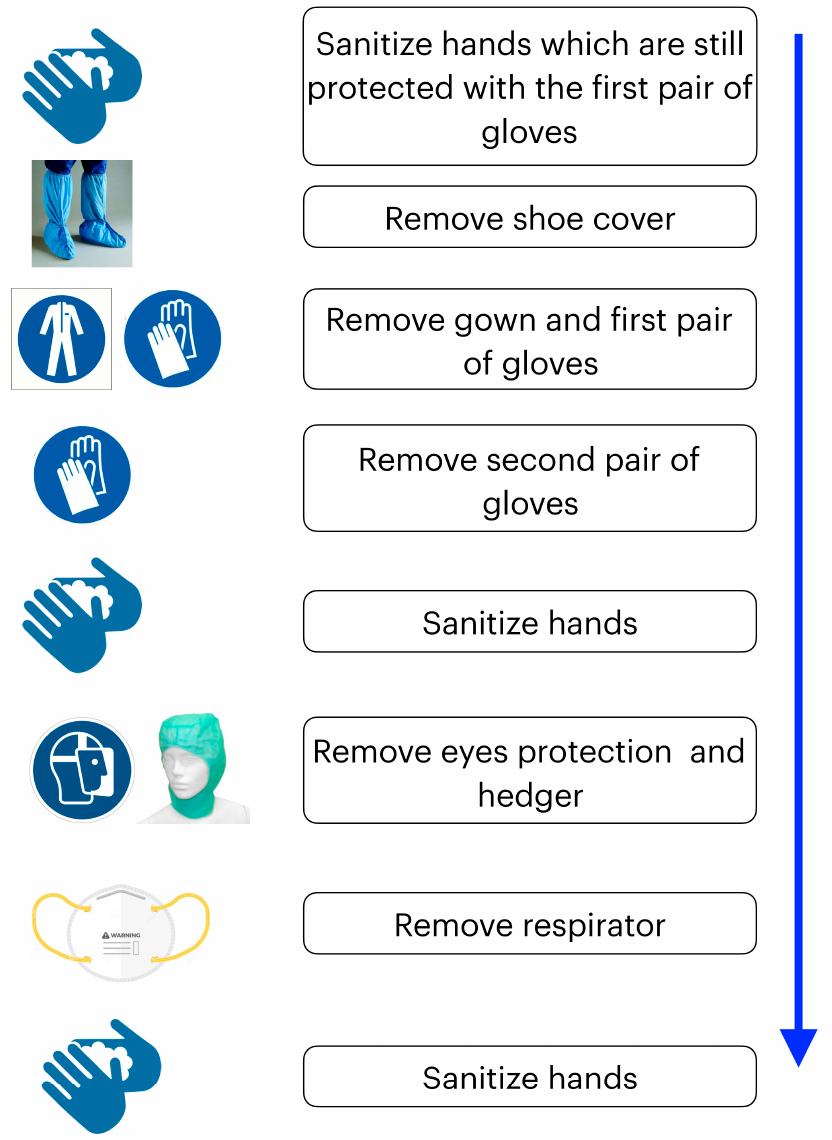
Figure 5. E ff ective sequence for the removal of Figure 5. Effective sequence for the removal of PPE.